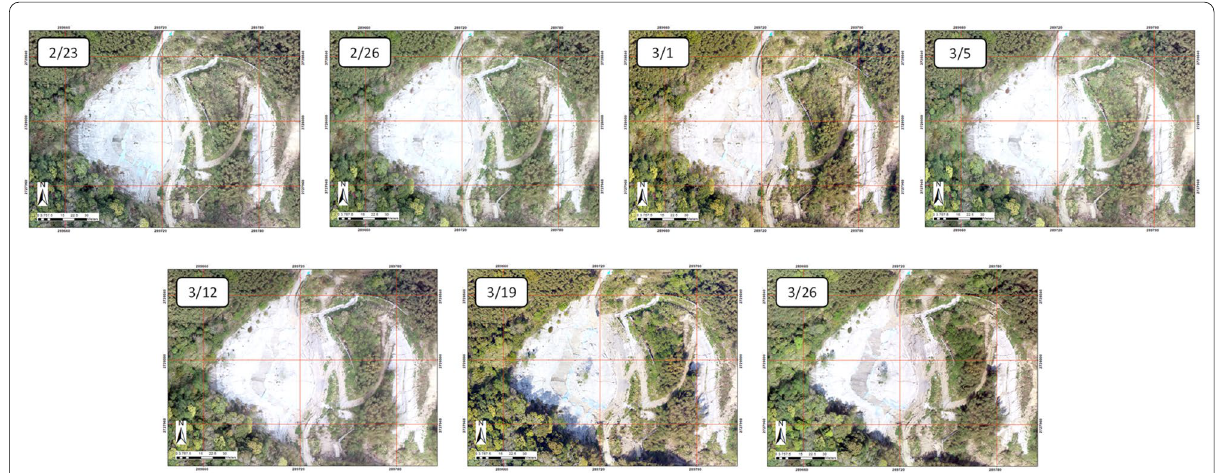
Fig. 15 Comparison of the top region of the sliding‑movement region in